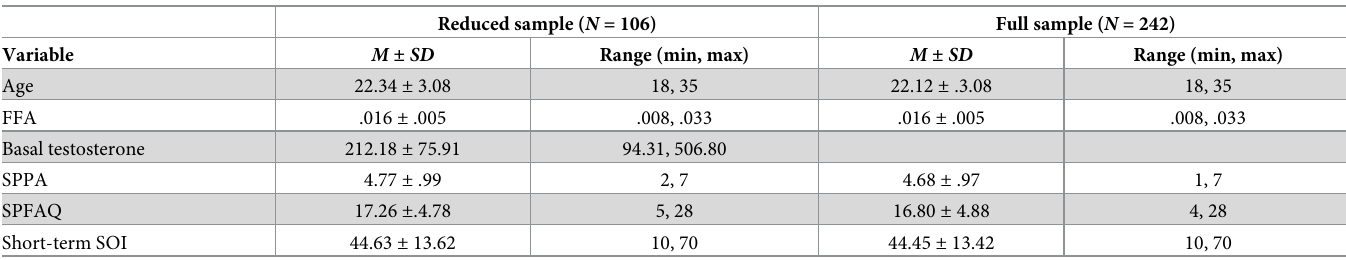
Table 1. Descriptive statistics for the variables employed in this study.